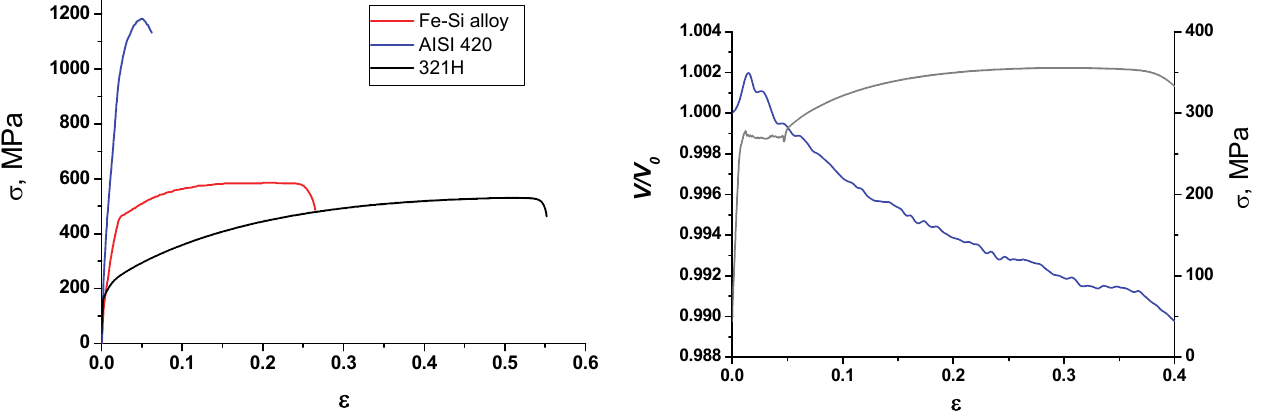
Figure 1: Stress-strain curves of the test materials. Figure 2: Stress and relative sound velocity versus the strain of steel